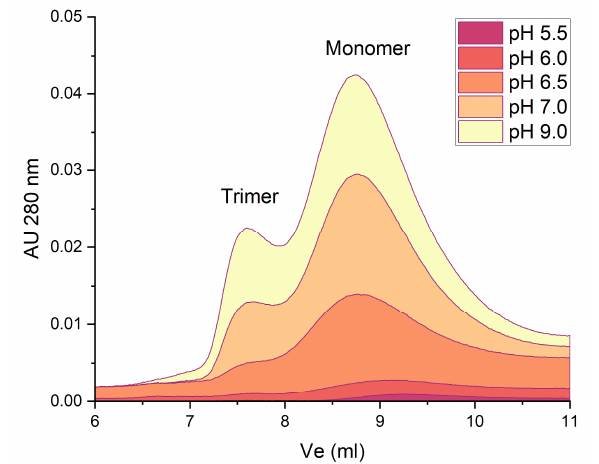
Figure 4. β-vignin trimer–monomer distribution at different pH values determined by SEC using a Superdex S75 10/300 column GL (30 cm × 10 mm). The calculated areas subtended to the peaks are reported in Supplementary Table S1. Protein molecular weight markers used for columns calibration and their elution volumes were the following: ferritin (MW 440 kDa) Ve = V0 = 7.5 mL; bovine serum albumin (MW 67 kDa) Ve = 7.8 mL; ovalbumin (MW 43 kDa) Ve = 10.3 mL; porcine trypsin (MW 23.3 kDa) Ve =13.1 mL; lyosyme (MW 14.2 kDa) Ve = 16.5 mL; porcine insulin (MW 5.7 kDa) Ve = 21.7 mL.